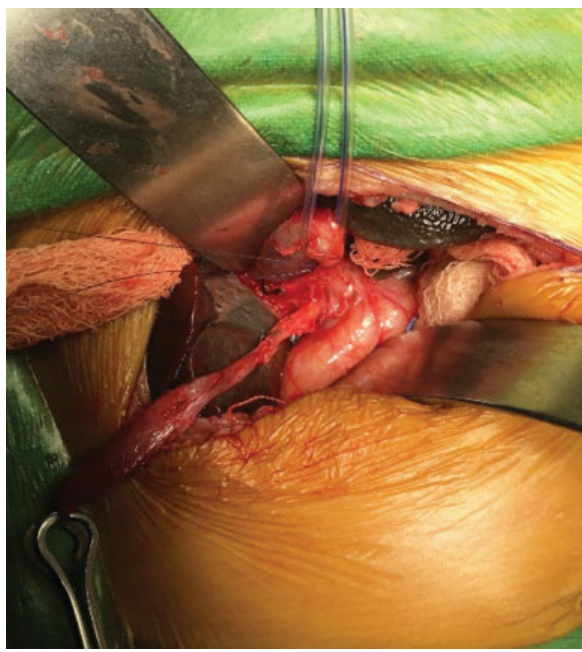
Fig. 4 Intraoperative image showing normal sized gall bladder, dilated common hepatic duct (cyst) and cystic duct noncommunicating with common hepatic duct.